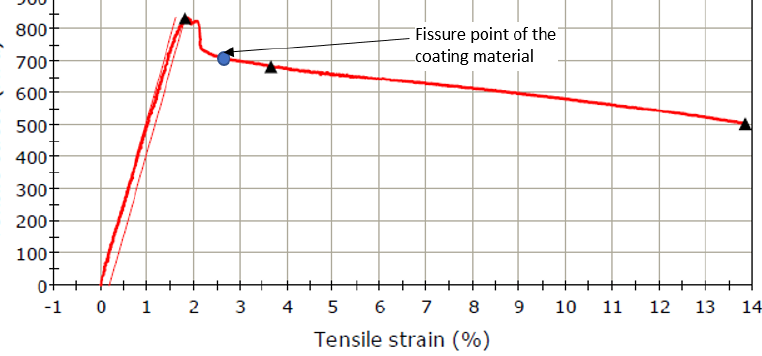
Figure 3. Characteristic stress-strain curve, specific to a coated sample. Figure 2. ( a ) The shape and dimensions of the sample (in mm). ( b ) Coated sample. ( c ) Attaching the sample to the testing machine.